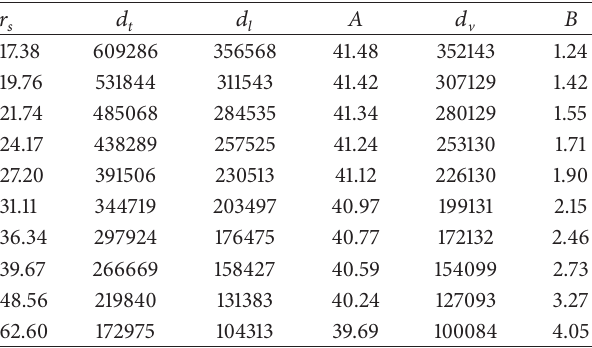
Table 1: Total distance traveled by MSNs in triangle, line, and vertex based